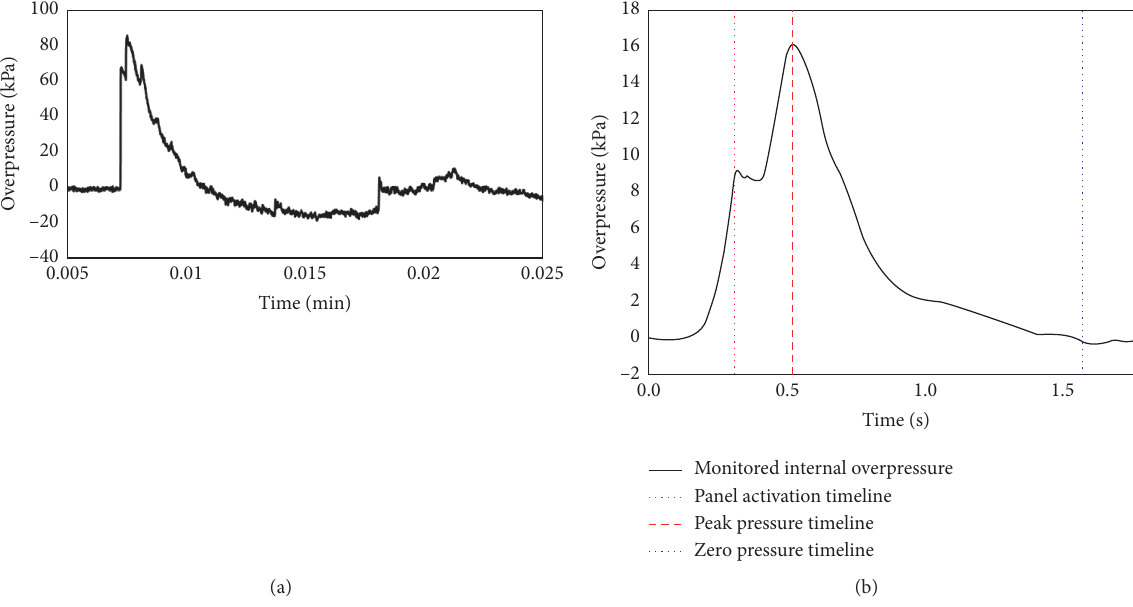
Figure 2: Examples of overpressure-time histories due to (a) an explosive or (b) a gas.